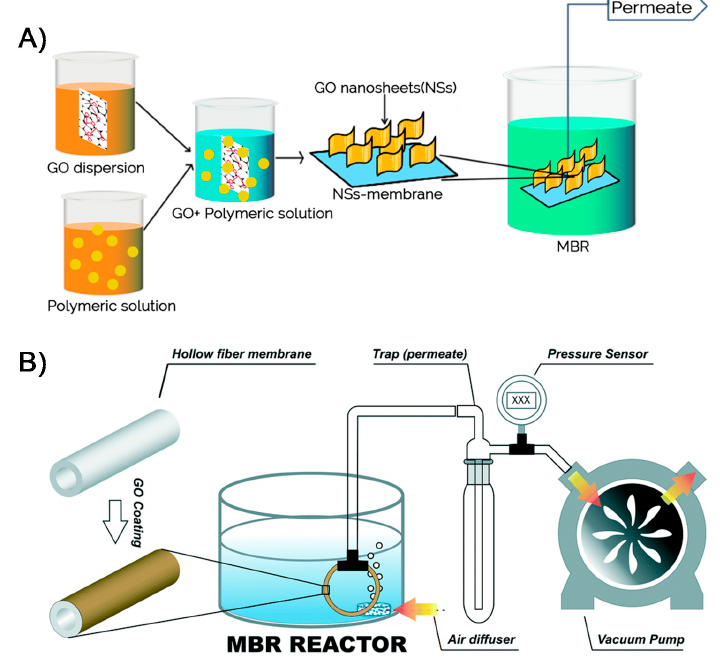
Figure 7. ( A ) A graphical illustration of GO-based membrane fabrication and use in MBR operation (reproduced from [114] with permission from the Springer Nature), and ( B ) schematic illustration of lab scale MBR (reproduced from [126] with permission from the Royal Society of Chemistry).